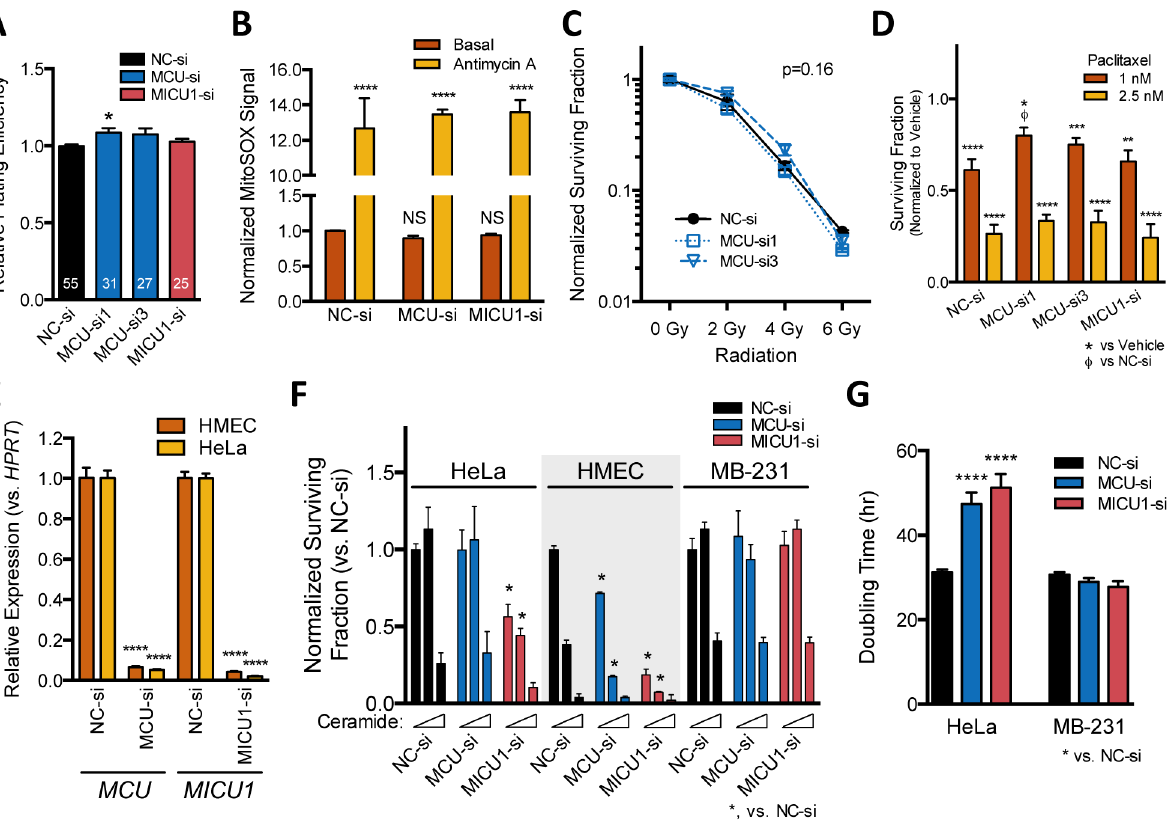
Figure 3. MDA-MB-231 ROS levels and sensitivity to therapy-related treatments are not mediated by MCU activity. A. Relative basal plating efficiency of MDA-MB-231 cells after siRNA-mediated knockdown normalized to control NC-si. (n=25–55). B. Mitochondrial superoxide levels determined by FACS analysis after incubating MDA-MB-231 cells with 2 m M MitoSOX. Maximal ROS production was induced by 10 m M antimycin-A. (n=6–7). C–D. Clonogenic survival assays of knockdown cells normalized to mock irradiated conditions ( C ) or DMSO vehicle ( D ). Prior to seeding, cells were irradiated with 2–6 Gy ionizing radiation (C, n=3) or treatment for 24 hr with paclitaxel (D, n=3–9). E. Knockdown efficiency of MCU and MICU1 by siRNAs in HeLa and primary HMEC cultures determined by qPCR. F. Clonogenic survival assays of siRNA transfected HeLa, HMEC, and MDA- MB-231 (MB-231) cells after 24 hr C2-ceramide treatment. The three bars grouped for each siRNA represent 0, 20, and 50 m M ceramide incubation, respectively (n=3–9). The surviving fraction was determined by normalizing the number of colonies to NC-si control conditions. G. Proliferation rate of HeLa and MDA-MB-231 (MB-231) cells after siRNA knockdown. Data are given as means + / 2 SEM and significance determined by one-way (A, E, G) or two-way (B–D, F)